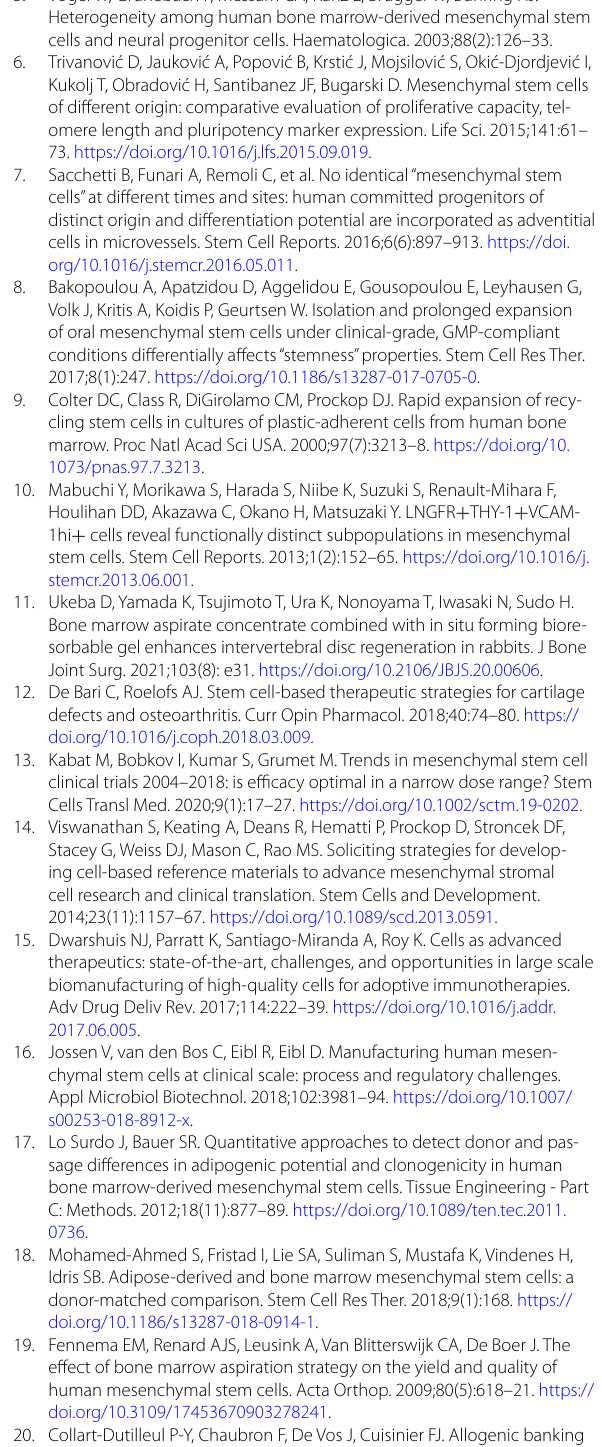
Additional file 5: Supplementary Table 3. Morphological descriptors used in LASSO